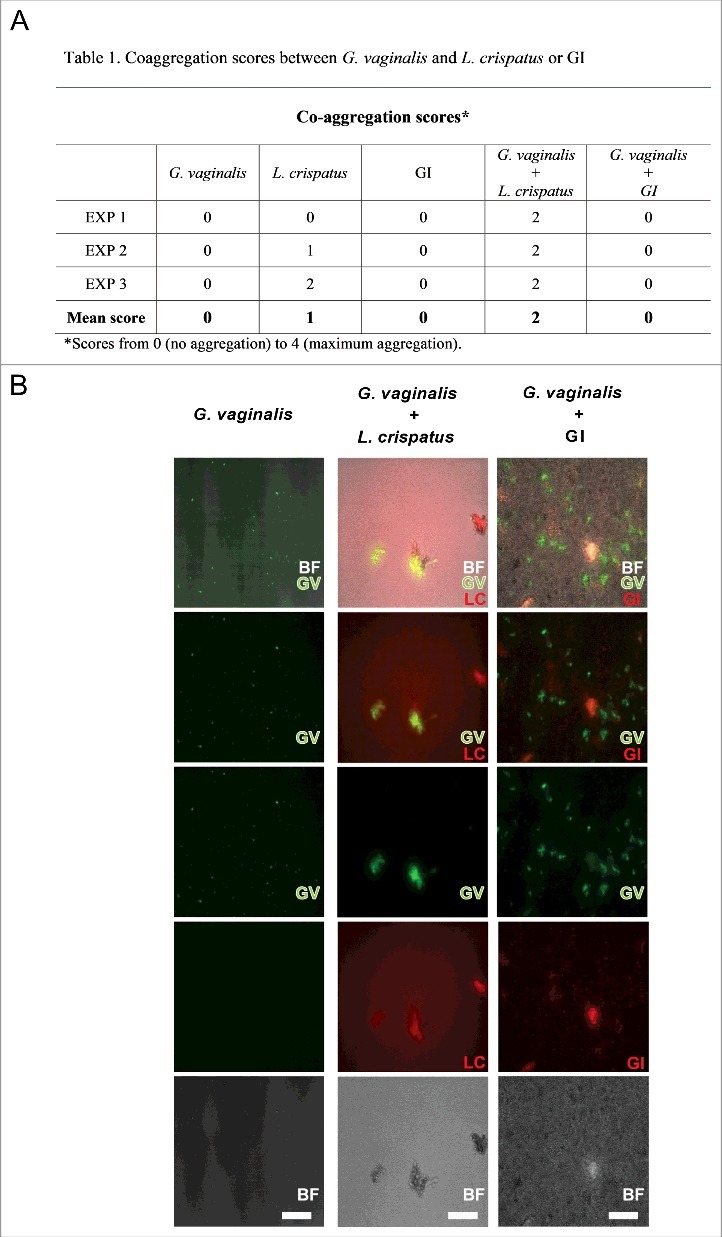
Co-aggregation between GI or L. crispatus and G. vaginalis. G. vaginalis or FITC-G. vaginalis (1 × 109/ml) in PBS were mixed with equal volume of L. crispatus or RhB-L. crispatus (1 × 109/ml) or with equal volume of GI or RhB-GI (108/ml). The samples were vortexed for at least 10 sec and incubated in a 24 well plate for 4 h at 37°C under agitation. The suspensions were, then, observed by inversion light microscopy to evaluate the aggregation degree or photographed by fluorescence microscopy. (A) Scores, from 0 (no aggregation) to 4 (maximum aggregation), and mean are shown. Data are from replicate samples of 3 different experiments. (B) Images are representative of 3 different experiments with similar results (Scale Bar = 50 µm, Magnification 20x). BF = bright field; G. vaginalis (GV) = green; L. crispatus (LC) = red.